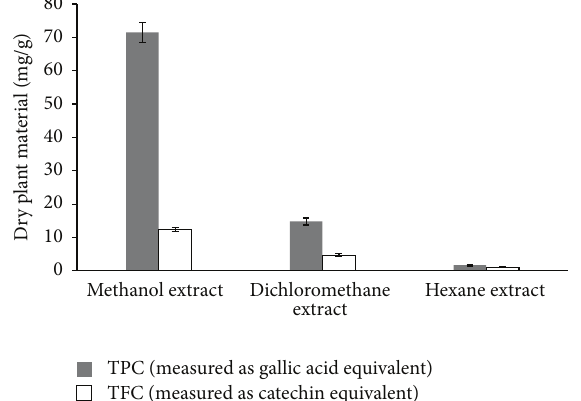
Figure 2: Total phenolics (TP) and total flavonoids (TF) contents of n -hexane, dichloromethane, and methanol extracts of M. longifolia .